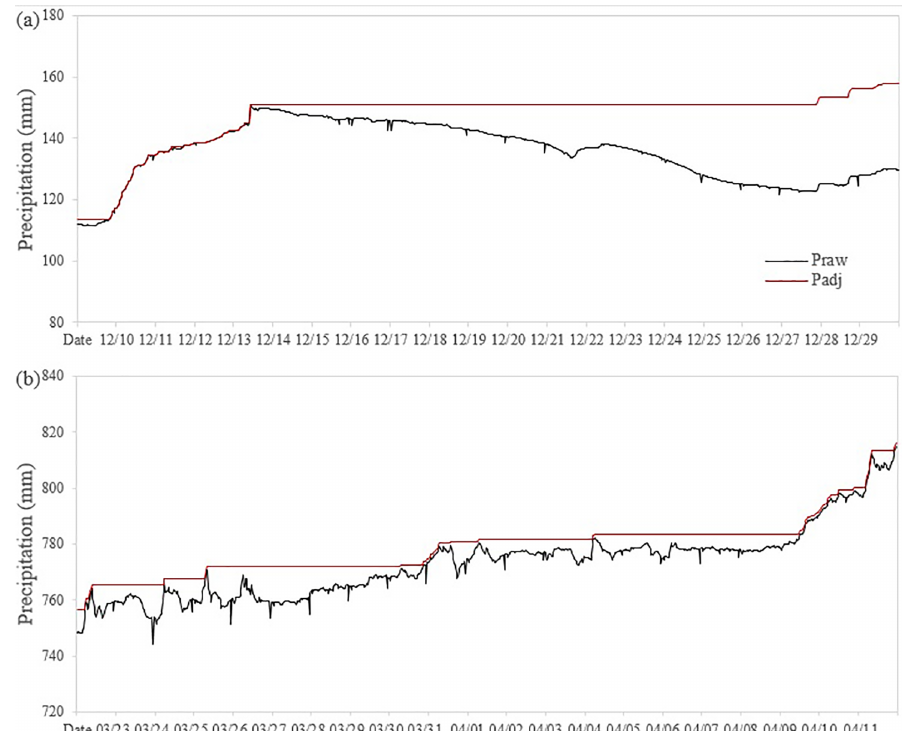
Figure 5. Examples of the jitters and diurnal noise filtering for Geonor T-200B weighing gauge (Praw: raw data; Padj: filtered data). (a) Significant evaporation occurred during winter season 2014 (e.g., MZA: 12–29 December 2013) and required manual correction (28– 29 December). No correction for the accumulation of raw precipitation between 22 and 23 December was made because the observed average humidity was below 15%. (b) Filtering of jitters and diurnal noise (no manual correction) (e.g., MZA: 23 March–11 April